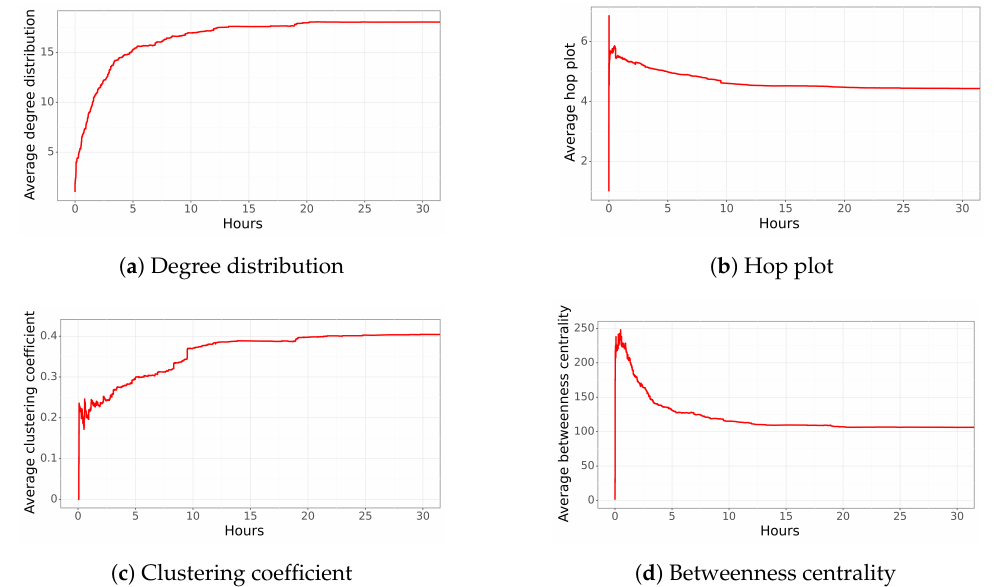
Figure 3. Average network characteristics for the funa against the former captain of the police over time. The X-axes of these plots are reduced from 1 week to 30 h to improve